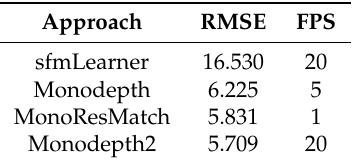
Figure 7. RMSE error over a sequence of arround 900 frames from the KITTI dataset. The blue, orange, green and red curves correspond respectively to the results of monodepth, monodepth2, MonoResMatch and sfmLearner approaches. Table 3. Experimental results of monocular approaches.